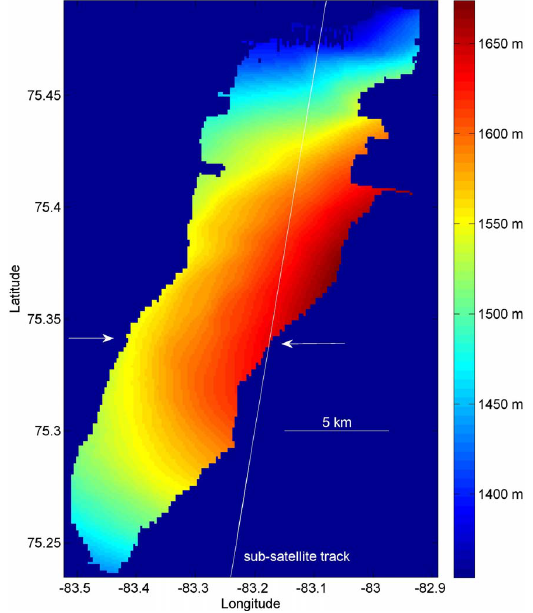
Fig. 7. Illustration of the swath processed geocoded elevations for the 23 February descending pass. The oblique white line indicates Figure 7. Illustration of the swath processed geocoded elevations for the Feb. 23 rd descending the sub-satellite track and the position of the maximum antenna pass. The oblique white line indicates the sub-satellite track and the position of the maximum gain. The two white arrows indicate the position of the E–W pass antenna gain. The 2 white arrows indicate the position of the E-W pass of the airborne ALS of the airborne ALS data which were used as a height reference. data which were used as a height reference.